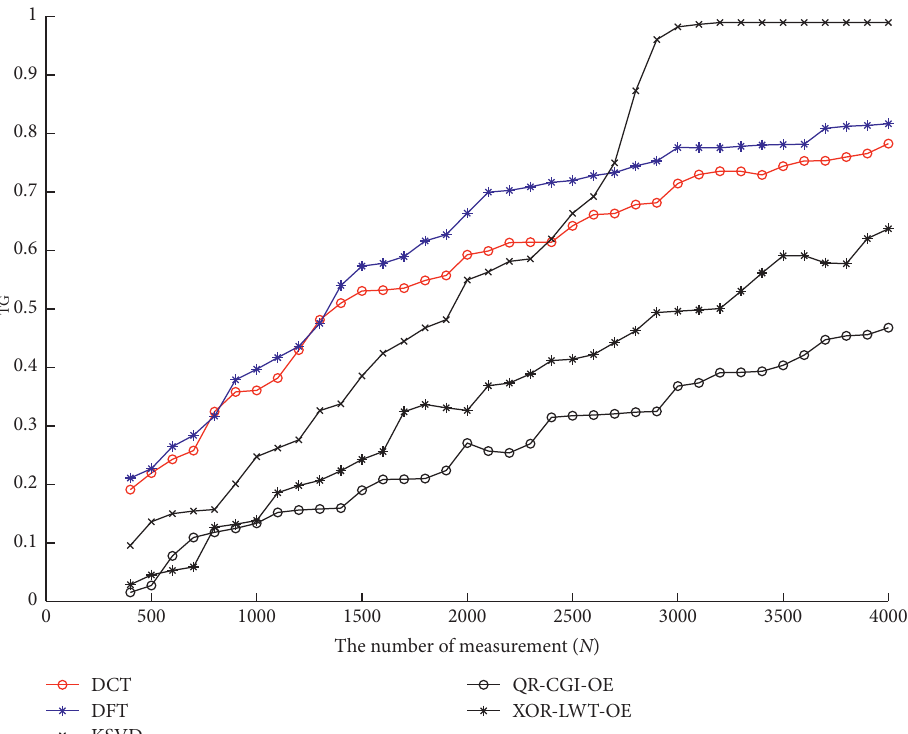
Figure 9: The relation curve of correlation coefficient r